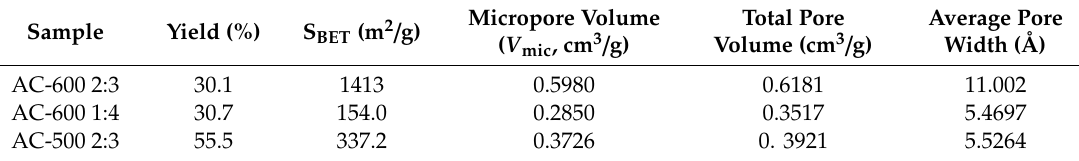
Figure 2. SEM micrograph of prepared adsorbents ( a ) AC-500 2:3; ( b ) AC-500 1:4; ( c ) AC-600 2:3; ( d ) AC-600 1:4. Table 1. Surface area and porosity of activated